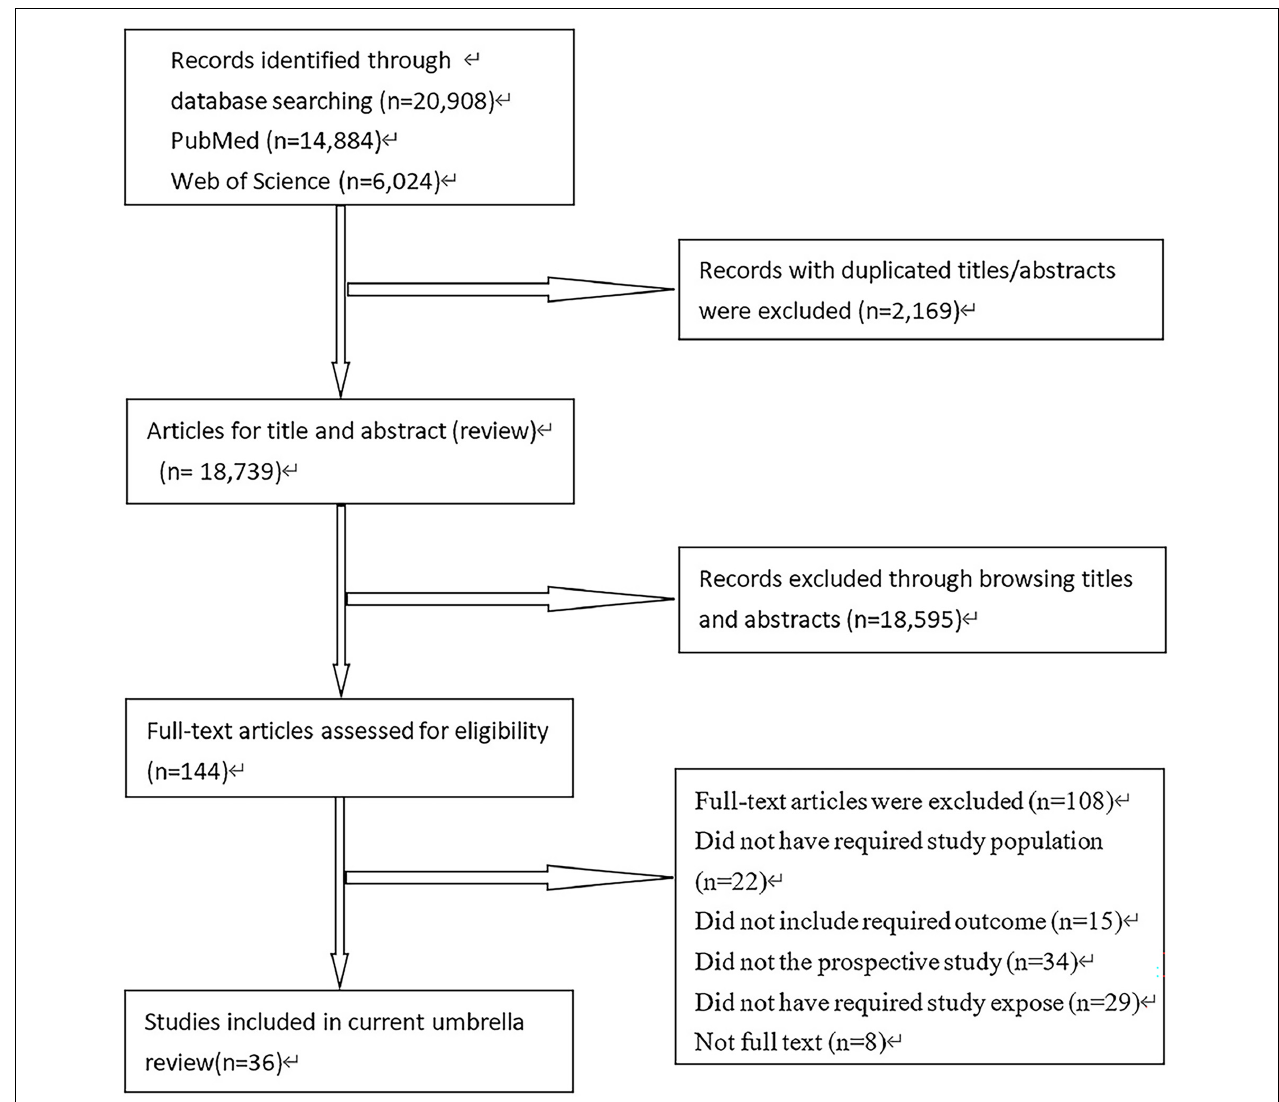
FIGURE 1 | Study selection process for this